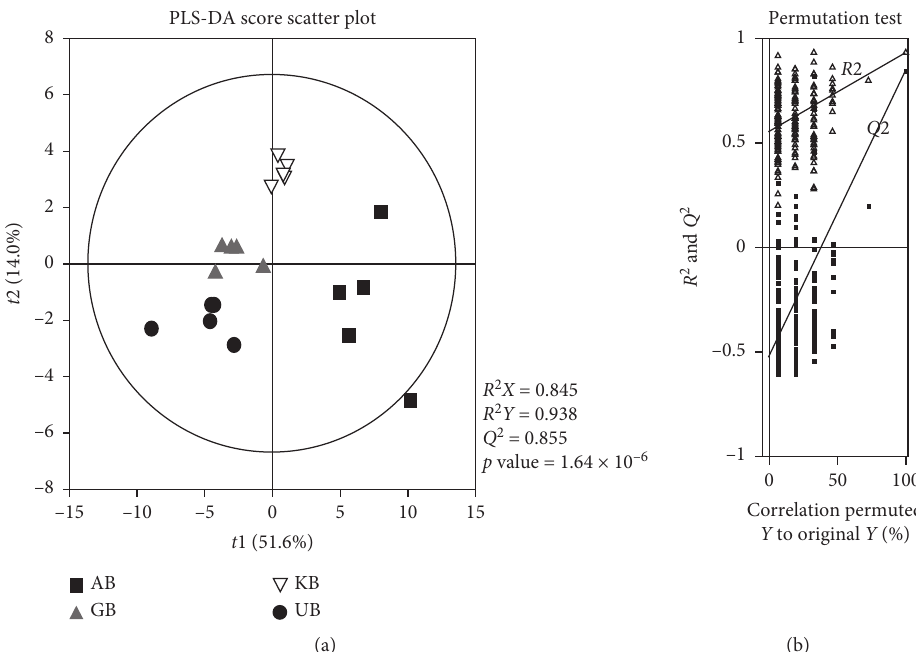
Figure 3: (a) PLS-DA score plot of volatile compounds obtained from GC-MS analysis of four wheat beer from grist containing 50% wheat malts. (b) The quality of PLS-DA score plots was evaluated using R 2 X , R 2 Y , Q 2, and p values and the permutation test validated by 200 times. GB, UB, KB, and AB represent wheat beers made of grist containing 50% of wheat malt from German, USA, and Korean wheat variety ( Keumkang and Anzunbaengi ), respectively.